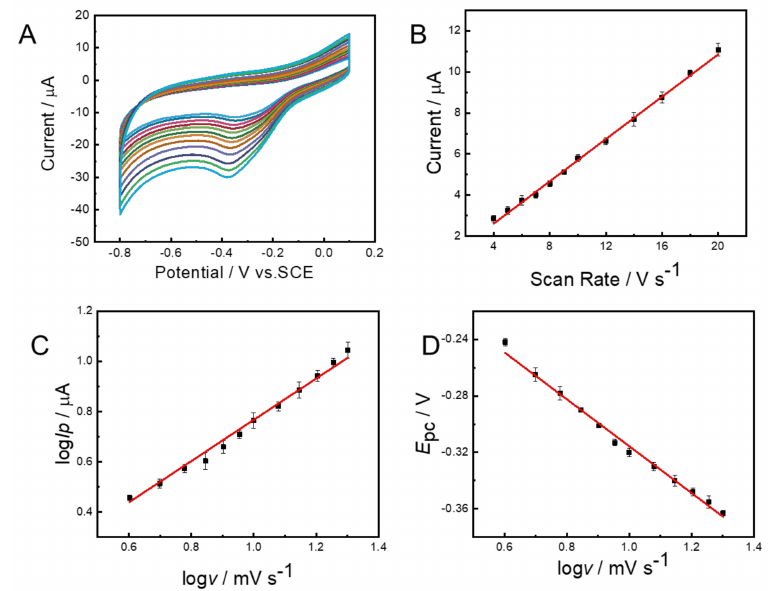
Figure 5. ( A ) CVs of the Fe-BC-900/GCE at different scan rates (40 to 200 mVs − 1 ) in 0.1 M. KOH containing 0.1 mM H 2 O 2 ; ( B ) the dependence of reduction current on scan rate; ( C ) the relationship between log I p and log v ; ( D ) the relationship between I pc and log v